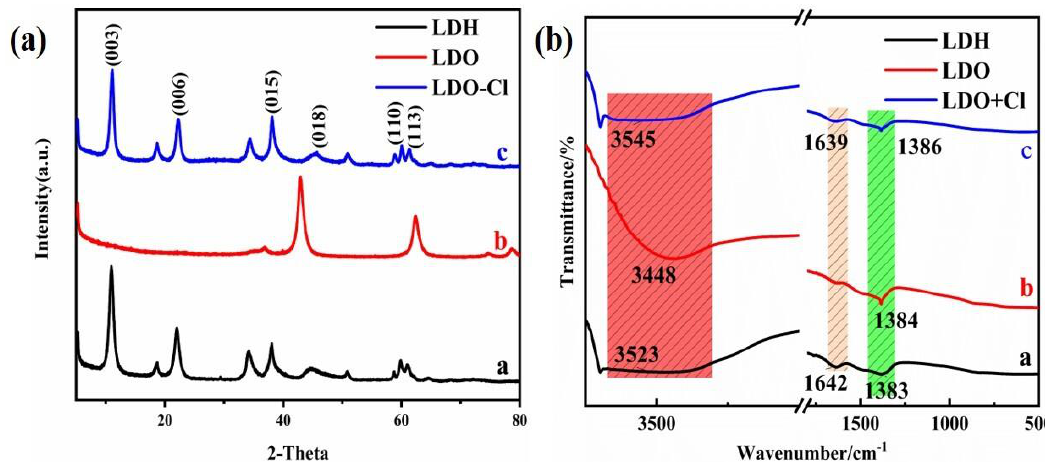
Figure 10. ( a ) X-ray diffraction analysis; ( b ) FT-IR spectra of the samples.